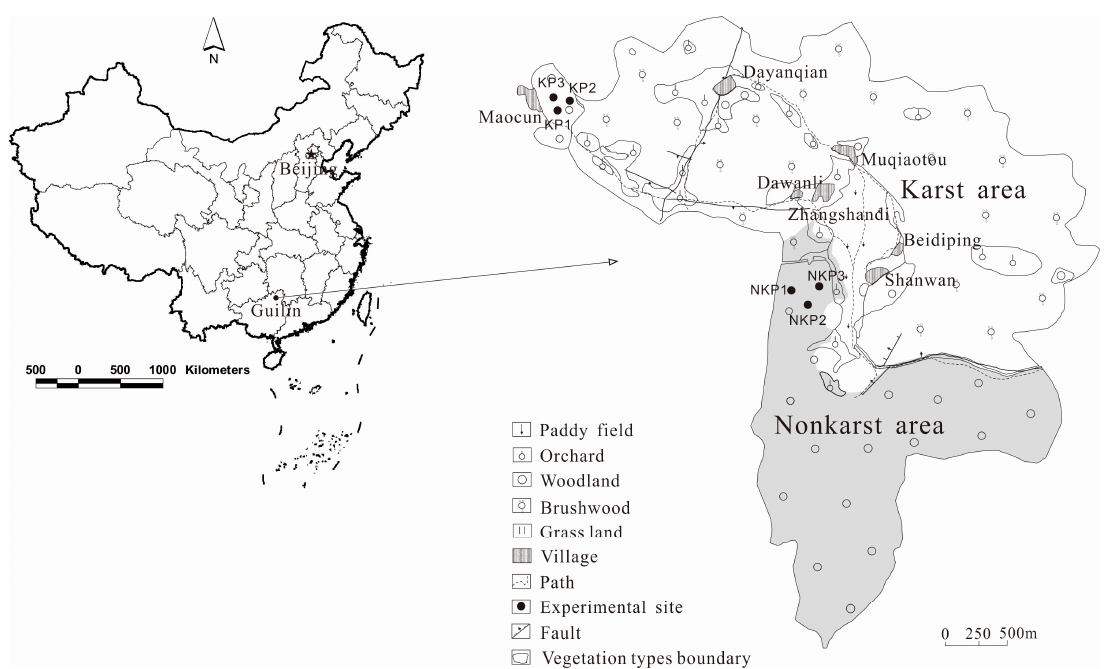
Figure 1. Land use of study area and location of study sites.